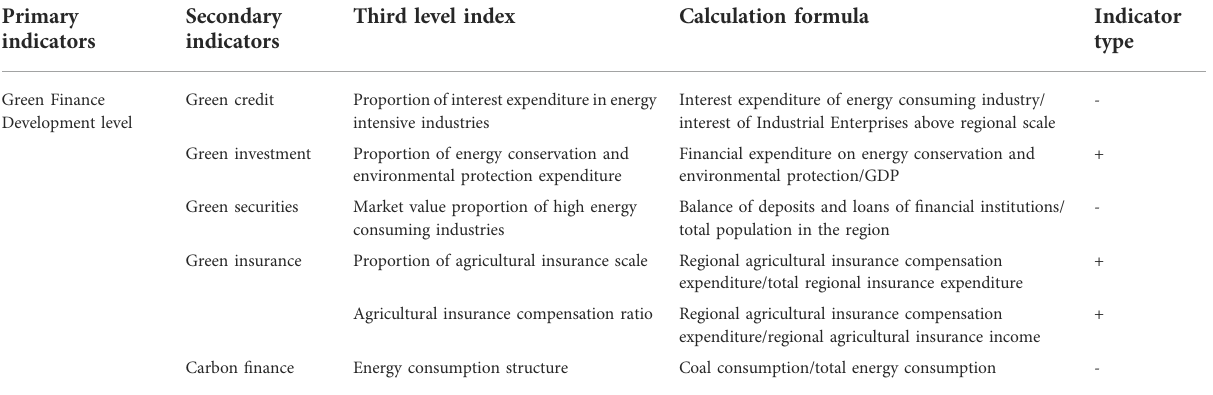
TABLE 1 Comprehensive evaluation index system of green fi nance development in